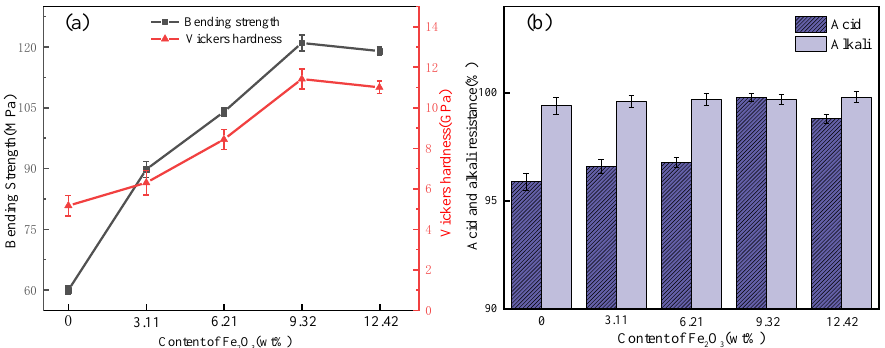
Figure 10. The physical and chemical properties of the samples: ( a ) mechanical properties; ( b ) chem- ical properties.